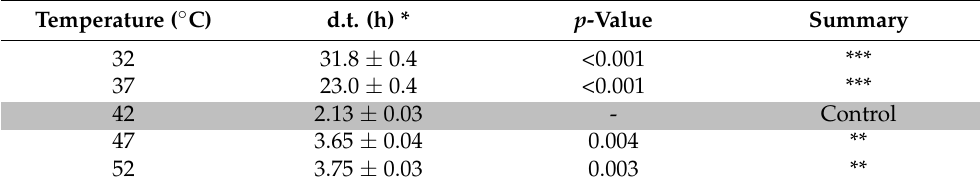
Figure 3. Effect of temperature stress on the growth profile of Hfx. mediterranei R4 grown in Hm-DM. Data are based on three independent cultures. ( a ) Maximum OD 600 in stationary phase (reached at different times). ( b ) Average growth rate. Plotted values are the mean of triplicate measurements, and error bars represent ± SD. * p ≤ 0.05; ** p ≤ 0.01; *** p ≤ 0.001. In grey, the control; in black, lower temperatures; in white, higher temperatures. Table 3. Doubling time of Hfx. mediterranei growth under different temperatures.